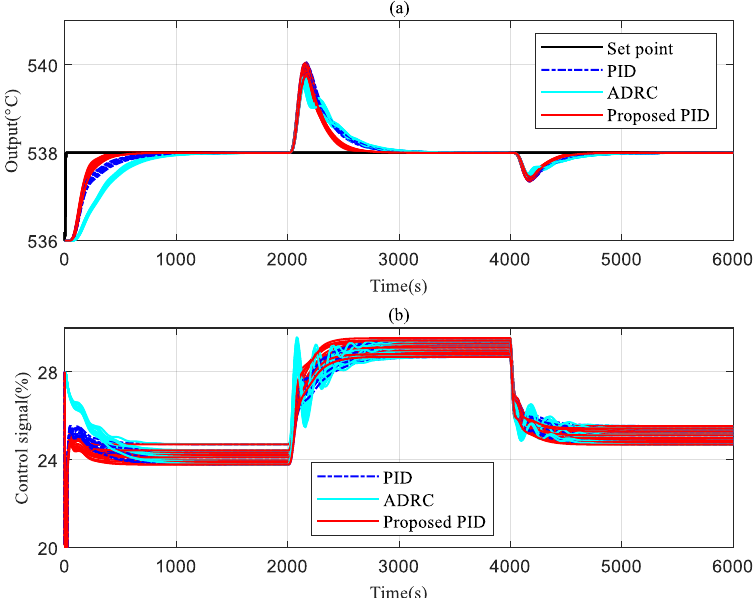
Figure 11. Control performance under an operating condition of 100% load with uncertainty in the SST system ( a ): outputs, ( b ): control signals.